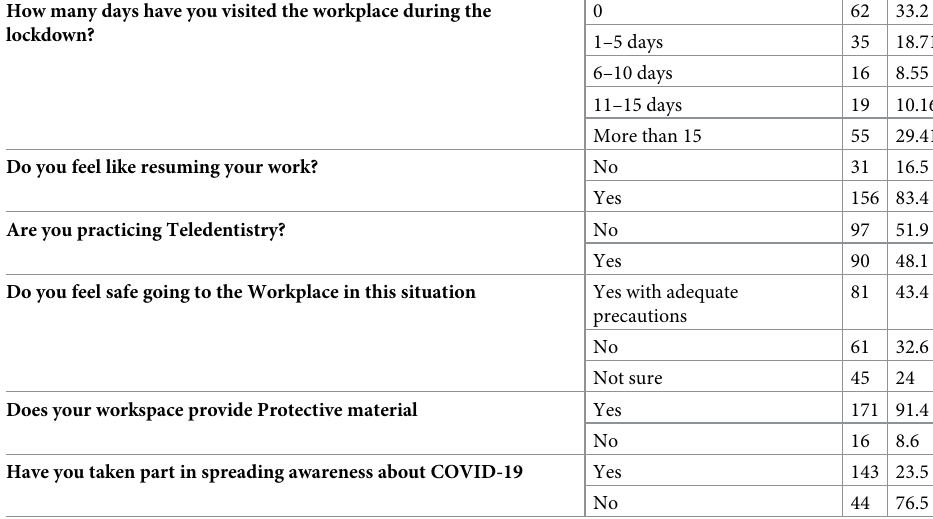
Table 3. Details of the workplace and preventive measure for COVID-19. How many days have you visited the workplace during the lockdown?